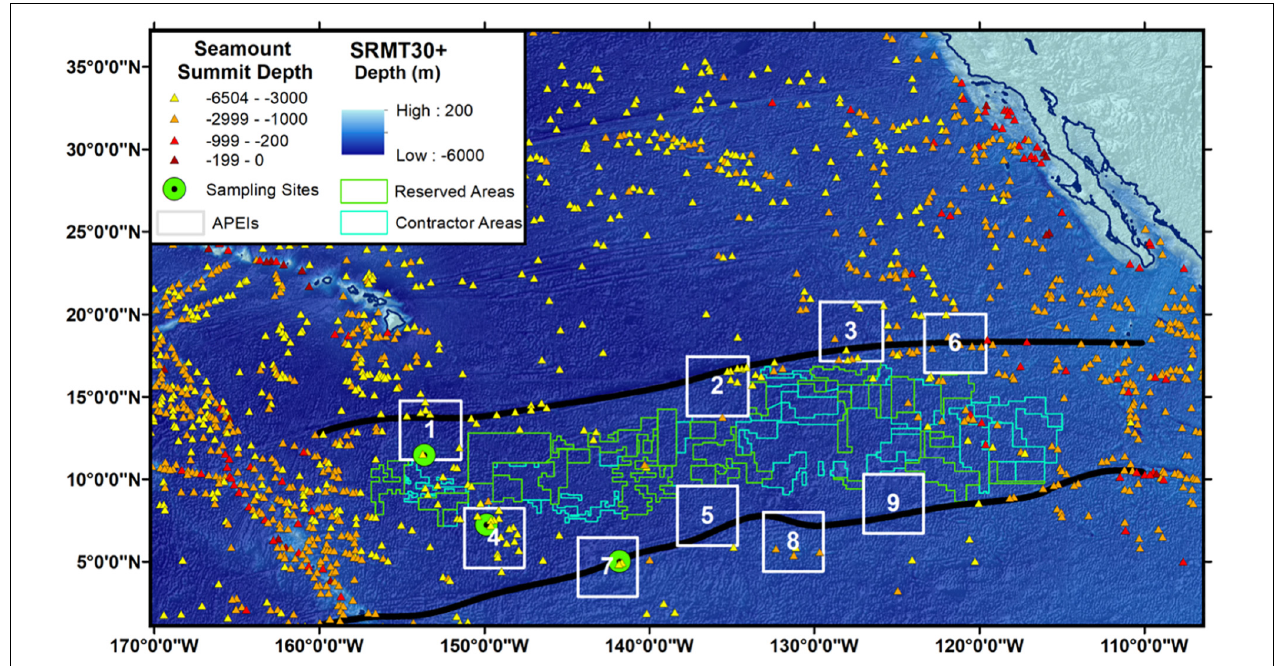
FIGURE 1 | Map of the CCZ (Clarion and Clipperton Fracture Zones are black lines) with sampling locations. Bathymetry data is drawn from the SRMT30 + satellite-derived bathymetry dataset (Becker et al., 2009). Satellite-estimated seamount locations and summit depths are plotted with abyssal seamounts in yellow, lower bathyal seamounts in orange, upper bathyal seamounts in red, and shallow seamounts in dark red (data from Yesson et al., 2011). Current regions licensed by the ISA for mining exploration are pictured as green polygons, areas currently reserved for future mining contracts are delineated by blue polygons, and Areas of Particular Environmental Interest (APEIs), i.e., areas currently protected from direct mining are shown, in white, with APEI number indicated. The Main Hawaiian Islands and the western coast of Mexico and California are shown.